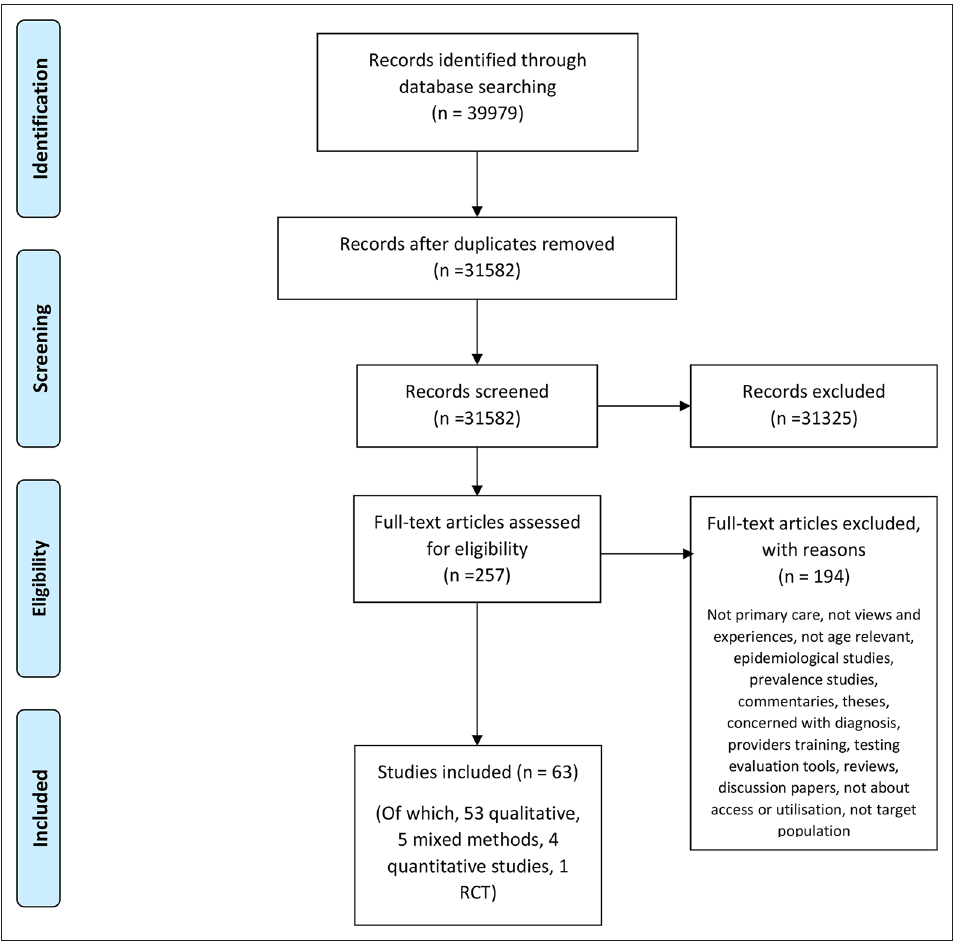
Figure 1 PRISMA diagram illustrating the literature search strategy. RCT = randomised controlled